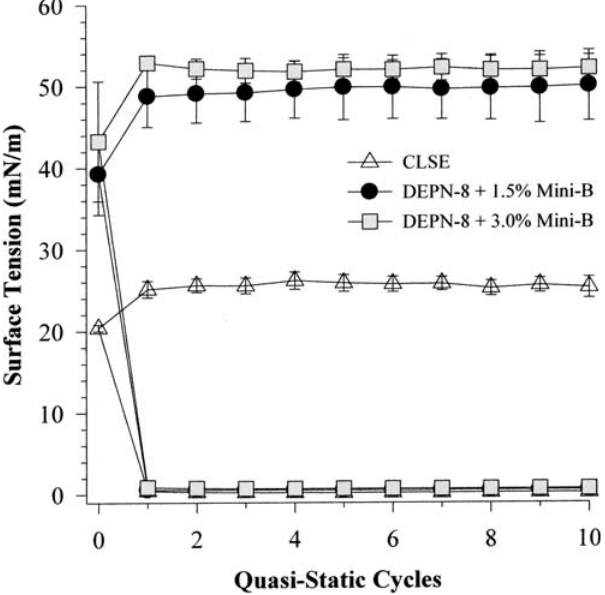
Figure 4. Surface activity of DEPN-8 + 1.5% (by wt) Mini-B and CLSE in the presence of bovine serum albumin. Surface tension at minimum radius (minimum surface tension) is graphed as a function of time for DEPN-8 + 1.5% Mini-B and CLSE in the presence of bovine serum albumin (3 mg/ml) on a pulsating bubble surfactometer (37 u C, 20 cycles/min, 50% area compression). Surfactant concentration was 2.5 mg/ml of phosphonolipid (phospholipid). Data are Mean 6 SEM for n=4–5.